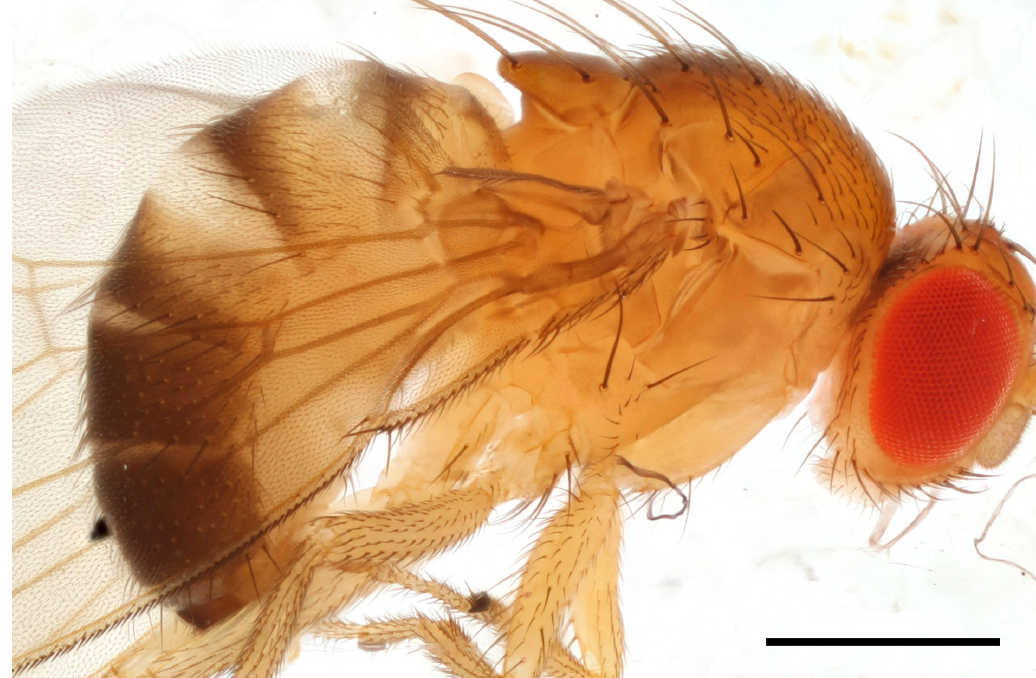
Fig. 2.10. Detail of a specimen stored in ethanol. A detailed lateral view of a Drosophila sp . Specimen submerged in a 70% ethanol solution. Scale = 500